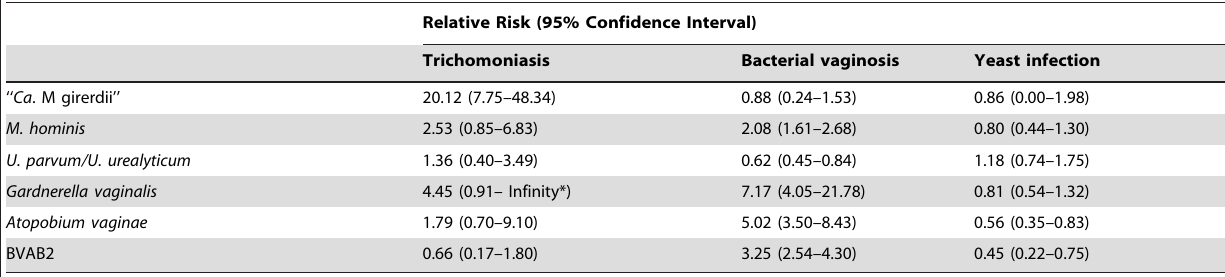
Table 2. Associations of vaginal carriage of bacterial taxa with common vaginal infections.